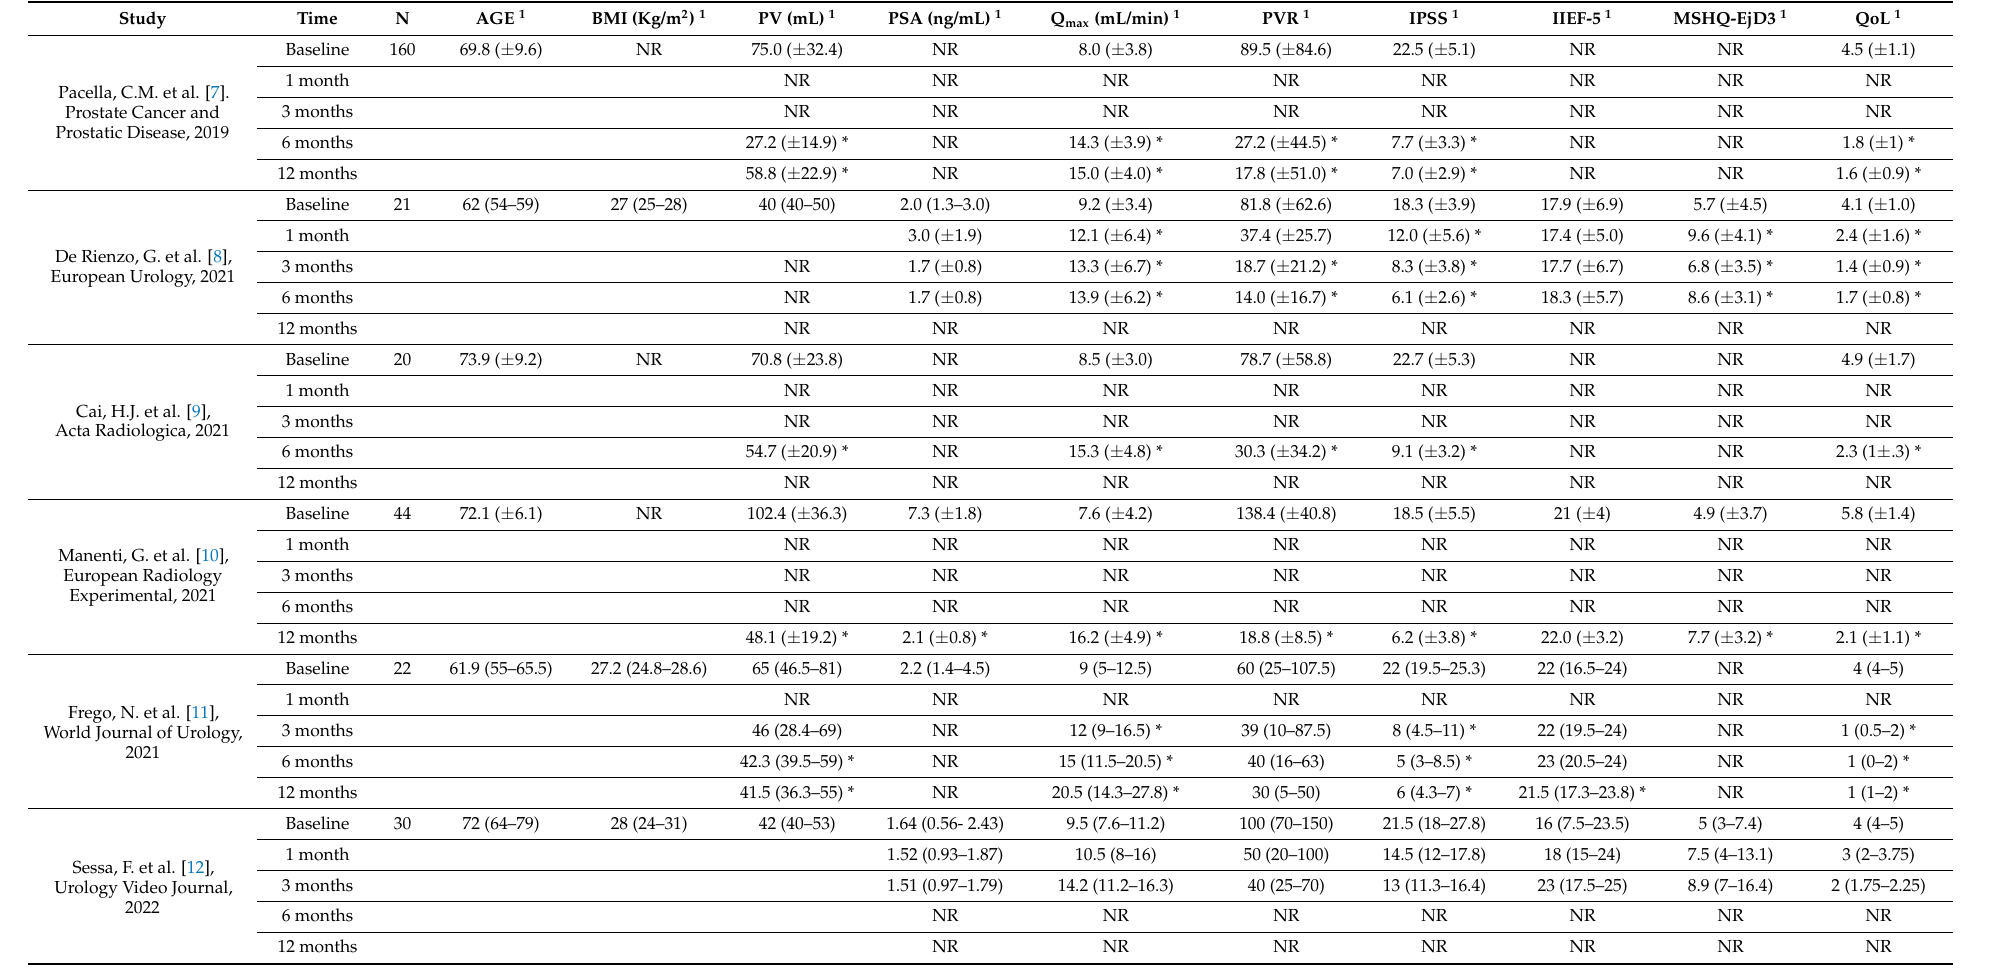
Table 4. Baseline patient characteristics and functional outcomes at 1, 3, 6, and 12 months of follow-up, for all the six included studies that evaluated the efficacy of transperineal laser ablation (TPLA) for benign prostatic enlargement